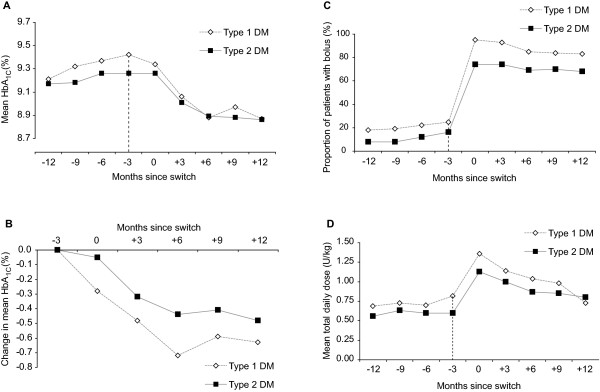
Mean HbA1c 12 months before and after switching from premix to glargine (A), mean change in HbA1c after switch (B), mean use of bolus insulin before and after switch (C) and mean total daily insulin dose before and after switch (D) (unadjusted data). The last measurement for premix is at -3 months (indicated by vertical dotted line). During period -12 m to -3 m patients are taking premix only. During the 3 month switch time point (0 months) patients may be prescribed premix and glargine. During period +3 m to +12 m patients are only prescribed glargine (± prandial boluses). Linearly interpolated data were used to graphically depict the change in each parameter. Linearly interpolated data affords a clearer graphical interpretation but may bias estimates of variance; as such error bars (95% confidence intervals for the means) are not reported. Total daily insulin dose was calculated according to the number of units prescribed divided by the number of days covered by the prescription.